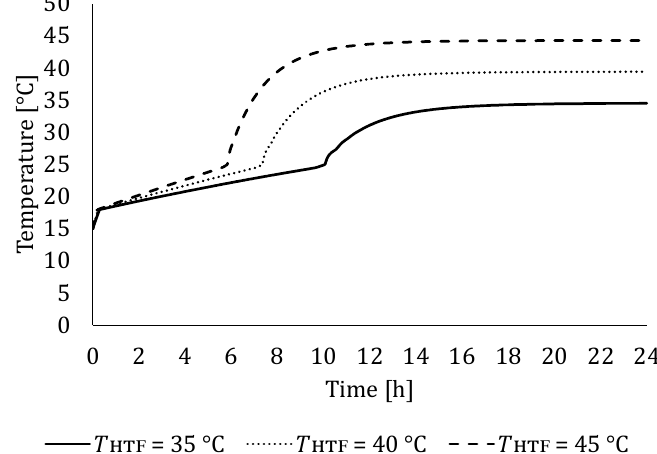
Figure 13. Comparison of transient variations of PCM temperatures during melting obtained numerically for different HTF inlet temperatures, HTF inlet flow rate 800 l/h and initial PCM temperature 15 °C.